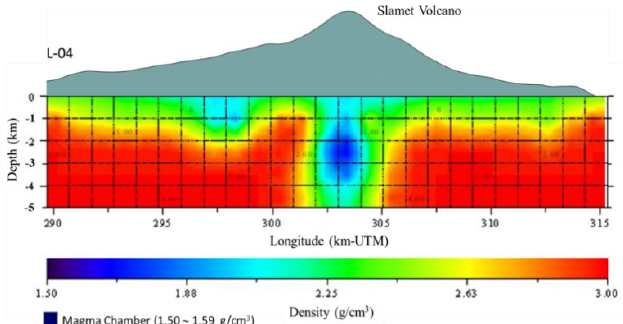
Fig. 12. A cross-section of the anomalous object model along L-03 trajectory at latitude of latitude of 9,199.560 km-UTM